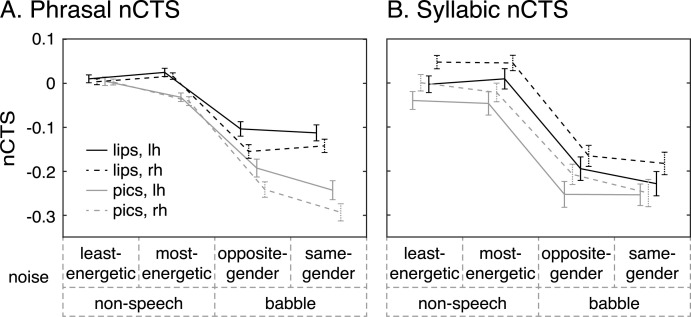
Impact of the main fixed effects on the nCTS at phrasal (A) and syllabic rates (B). Mean and SEM values are displayed as a function of noise properties. The four traces correspond to visual conditions with the speaker’s talking face visible (lips; black traces) and with static pictures illustrating the story (pics; gray traces), within the left (lh; connected traces) and right (rh; dashed traces) hemispheres. nCTS values are bounded between −1 and 1, with values below 0 indicating lower CTS in speech-in-noise conditions than in noiseless conditions. S2 Data contains the underlying data for this figure. lh, left hemisphere; nCTS, normalized cortical tracking of speech; rh, right hemisphere.